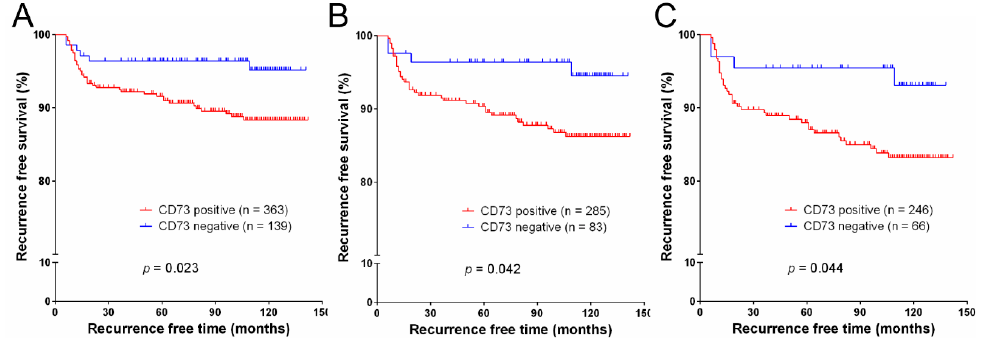
Figure 2. Recurrence-free survival analysis of CD73 expression in patients who underwent thyroid surgery for papillary thyroid carcinoma. ( A ) The recurrence-free survival in 502 patients is significantly correlated with CD73 expression. Stratified survival analyses show a significant association between CD73 expression and recurrence-free survival in 368 patients with extrathyroidal extension ( B ) and in 312 patients with lymph node metastasis ( C ).